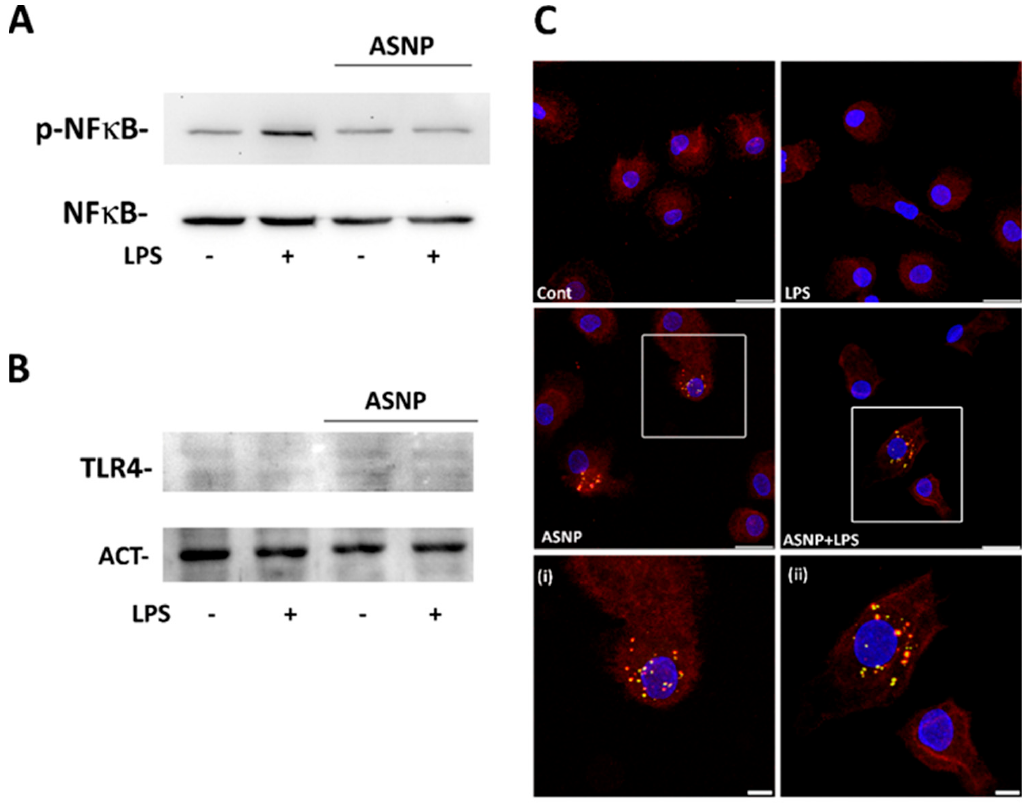
Figure 3. ASNP impact on LPS − dependent NF κ B activation and TLR4 distribution. Macrophages were exposed to ASNP, as described above, and then incubated in the presence or in the absence of LPS 1 ng/mL for 30 min ( A ) or 24 h ( B , C ). After the experimental treatment, cells were processed for Western blot or immunocytochemistry. ( A , B ), Two representative Western blots performed twice with comparable results. ( C ), Maximal projection of single confocal sections of representative fields of MDM cultures stained for TLR4 (red) and LAMP1 (green). Nuclei are counterstained in blue (Bars = 20 µ m); ( i ) and ( ii ), magnifications of the regions of interest highlighted in the whole fields (Bars = 5 µ